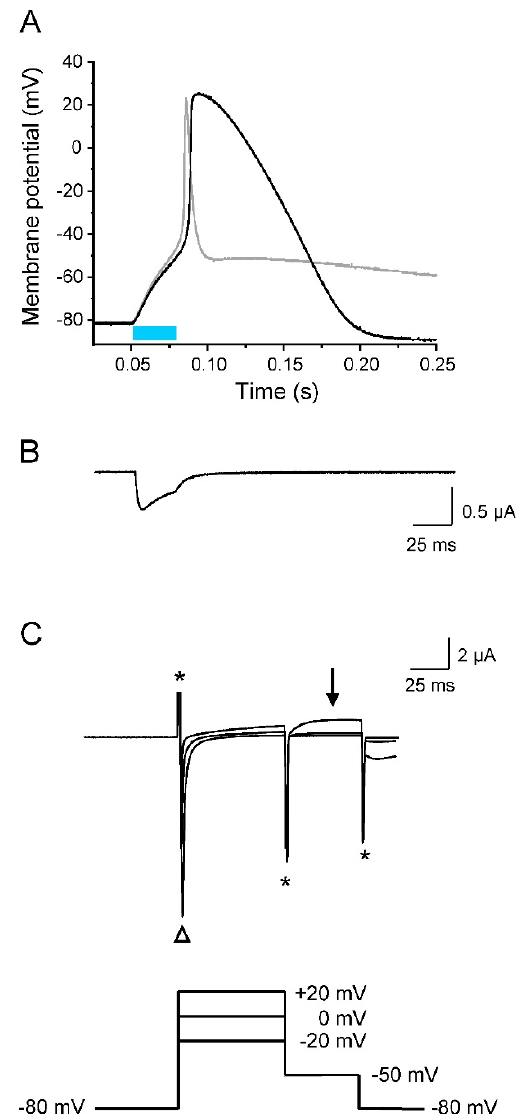
Figure 8. Pronounced late AP repolarization by hERG. All recordings were performed on the same oocyte co-expressing Na v 1.5-CC-2 and hERG. Plots are in the same timescale. ( A ) Current-clamp recording (light pulse duration 30 ms). For comparison, the gray line represents an AP obtained after co-expression of K v 1.2 (shown in Figure 6A). ( B ) Corresponding whole-cell photocurrent (voltage-clamp mode), resulting in initial membrane depolarization to the threshold potential. ( C ) Whole-cell ionic currents elicited by three different prepulses followed by a second pulse to − 50 mV. Asterisks indicate the capacitive currents. The open triangle indicates the fast Na + inward current through Na v 1.5-CC-2, responsible for AP upstroke. In contrast to K v 1.2, initial prepulses caused small outward currents through hERG channels. Correspondingly, early AP repolarization is less efficient (see also data for APD − 10 mV and − 40 mV in Table 3). Stepping back to − 50 mV from +20 mV, however, resulted in hERG activation, pronounced outward rectification (arrow), and hyperpolarization of the oocyte membrane (seen in ( A ) and in Figure